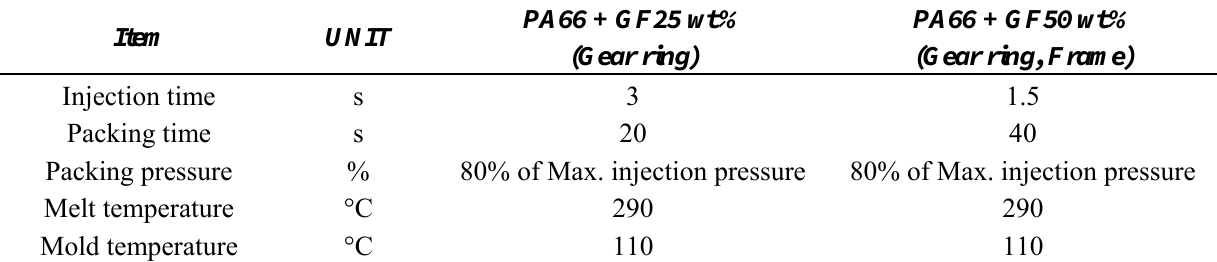
Table 5. Strain-stress comparison analysis according to glass fiber contents.